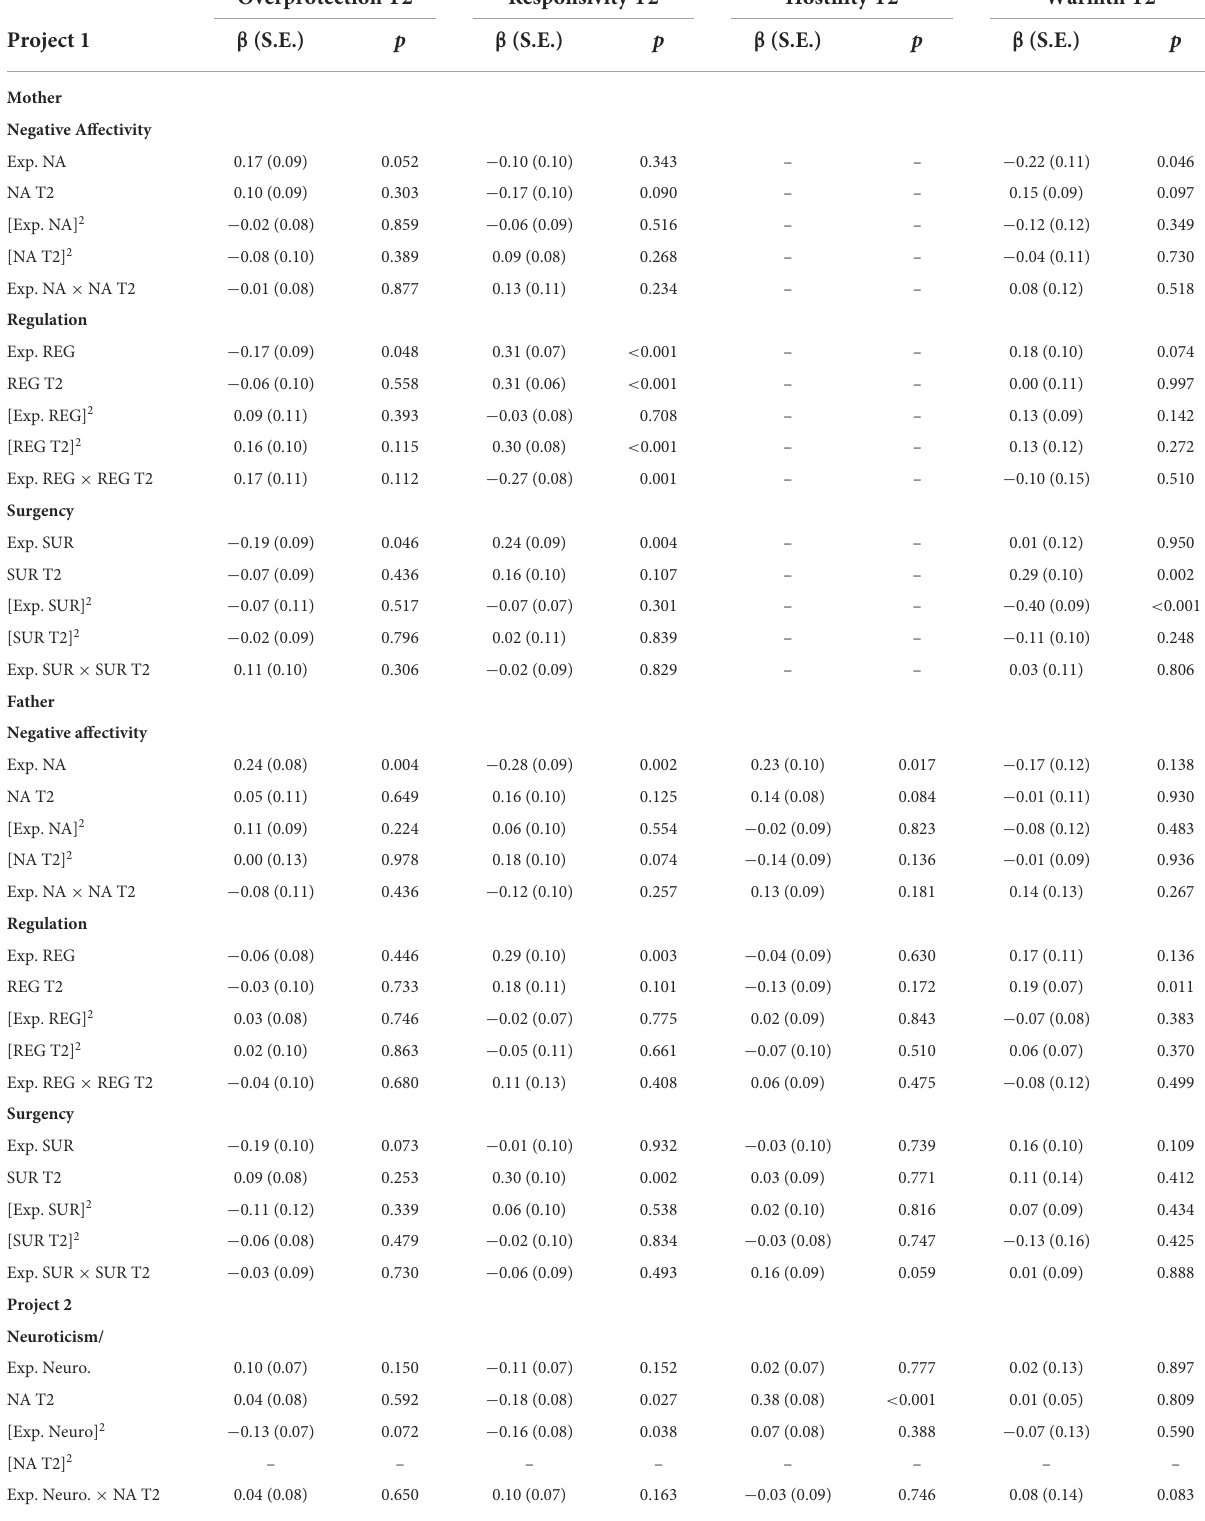
TABLE 5 Effects of expected temperament T1, infant temperament T2, and their interaction on parenting. Overprotection T2 Responsivity T2 Hostility T2 Warmth T2 Project